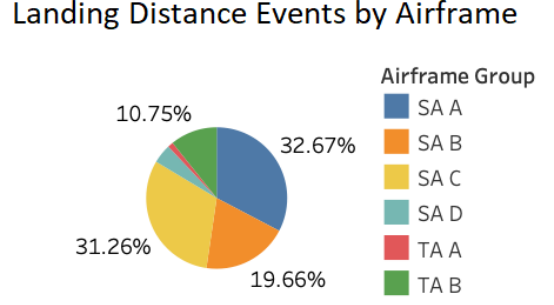
Figure 6. Airframe-based analysis showing the distribution of landing distance events by airframe